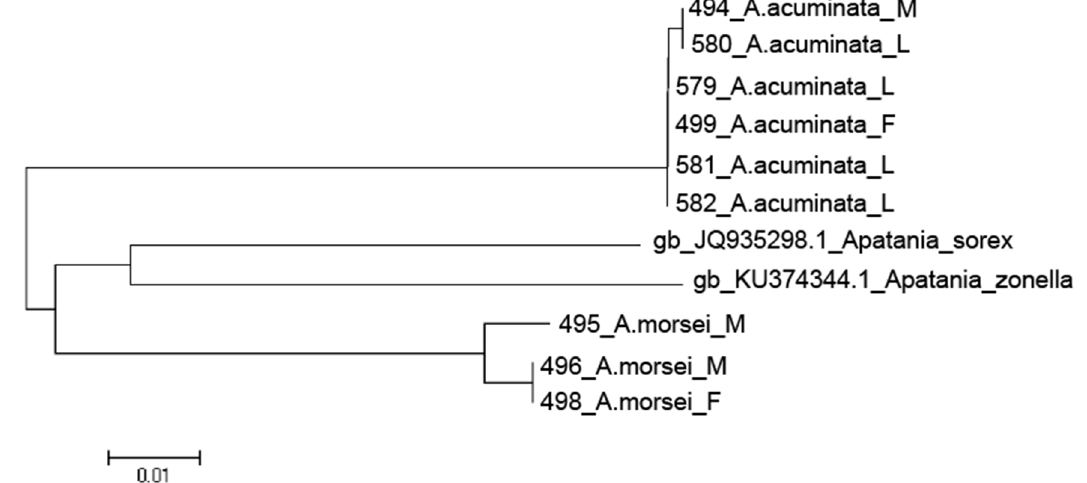
Fig. 1. COI neighbour-joining diagram used to determine larval-female-male associations of species of Apatidelia in China. M = ♂; F = ♀; L =